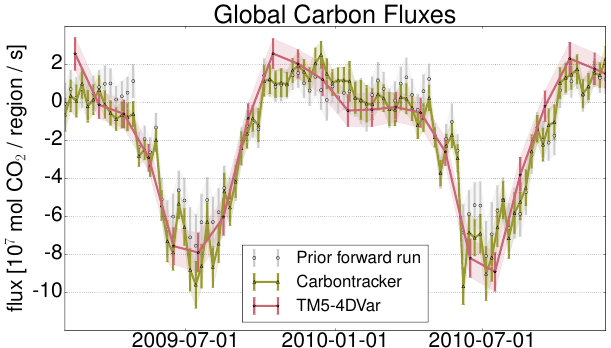
Figure 7. Global fluxes from the baseline runs of TM5-4DVar and CarbonTracker. The Prior is shown in the binning from Car- bonTracker. The uncertainties shown for CarbonTracker are aggre- gated spatially but not temporally. As such they represent the uncer- tainty of the estimated fluxes, calculated directly from the ensem- ble. These uncertainties are excluded from the annually aggregated graphs, because there is no method for temporally aggregating the uncertainties in a way which is comparable to the uncertainties es- timated by TM5-4DVar.